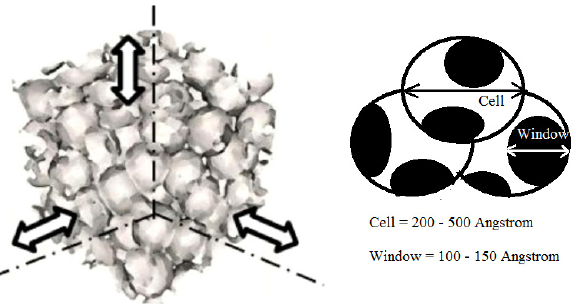
Figure 2: Three-dimensional cells and windows in MCF silica material (adapted from